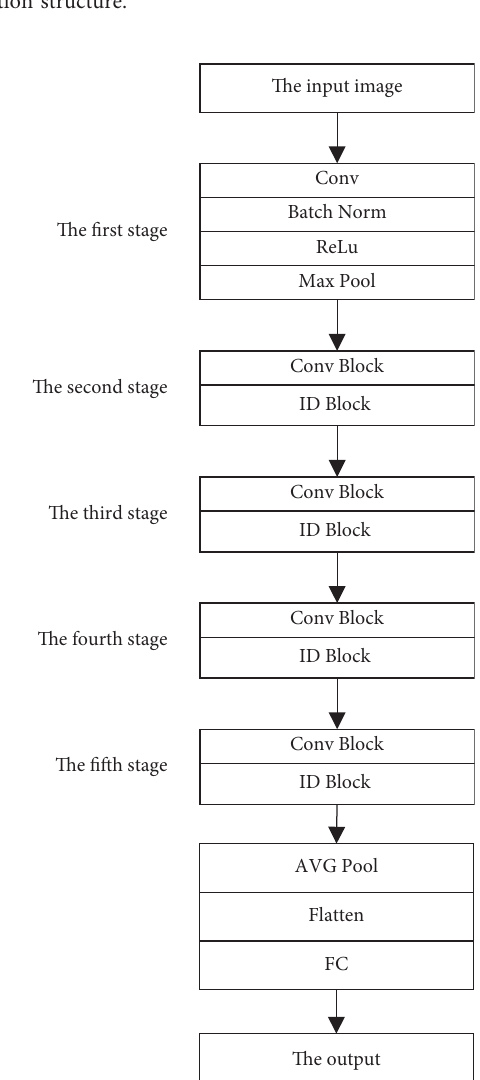
Figure 4: ResNet-50 network